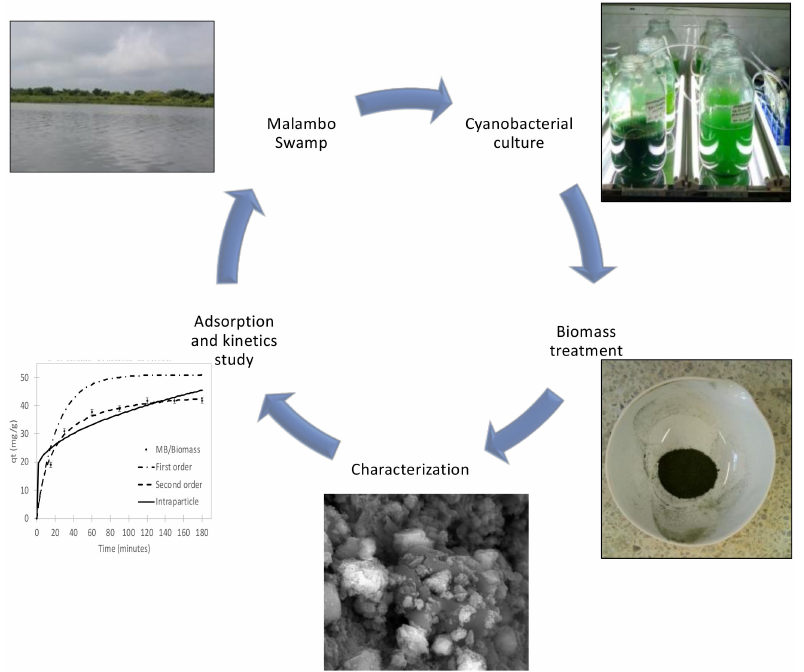
Figure 2. General procedure. The samples were obtained from Ci é naga Grande de Malambo, and were subjected to cyanobacteria culture and biomass extraction, physical-chemical biomass treatment, characterization, and kinetic